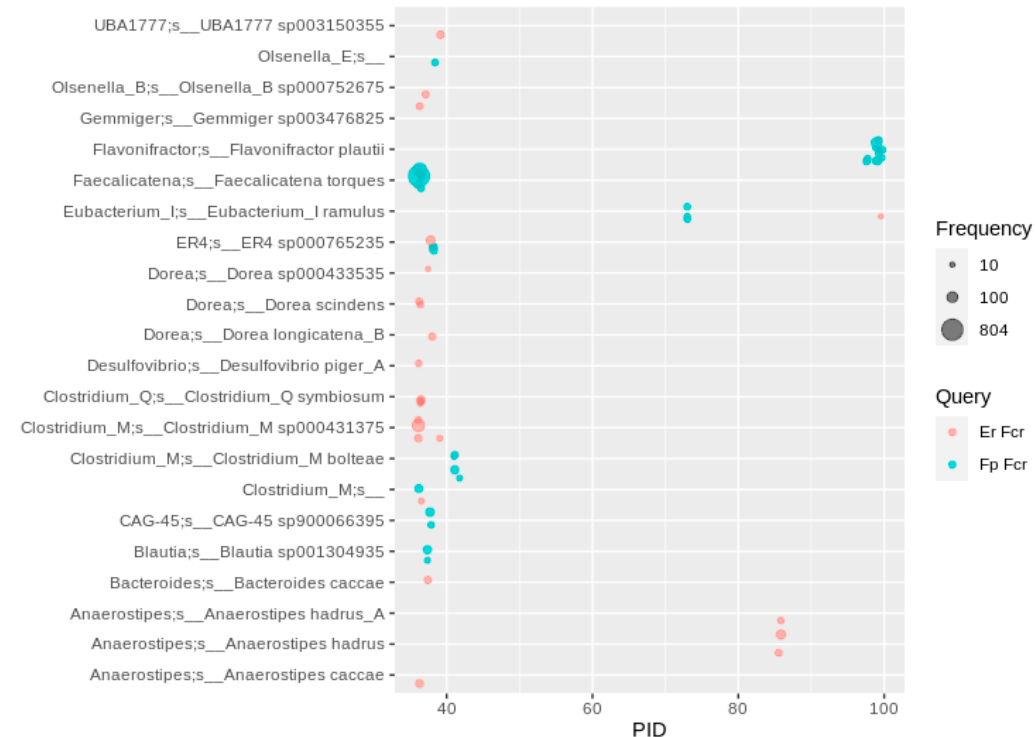
Figure 7. Flr sequence hits of human gut MAGs. A PID threshold of 40 was chosen to the queries shown in the color code (for abbreviations and details see Table 1). Hits were filtered for at least 10 occurrences, so that each bubble represents a number of redundant sequences ranging from 10 to 245.